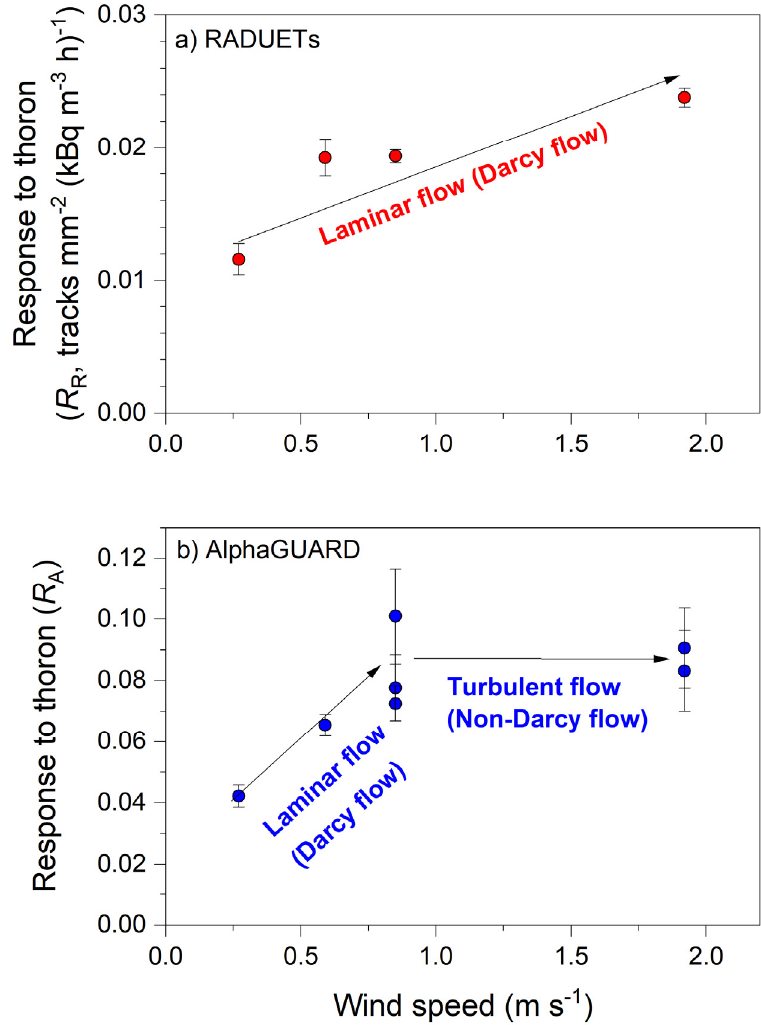
Figure 4. Scatter plots of responses of the RADUETs ( a ) and the AlphaGUARD ( b ) to thoron with respect to wind speed in the thoron calibration chamber. Bars on datapoints represent ranges of one standard deviation.